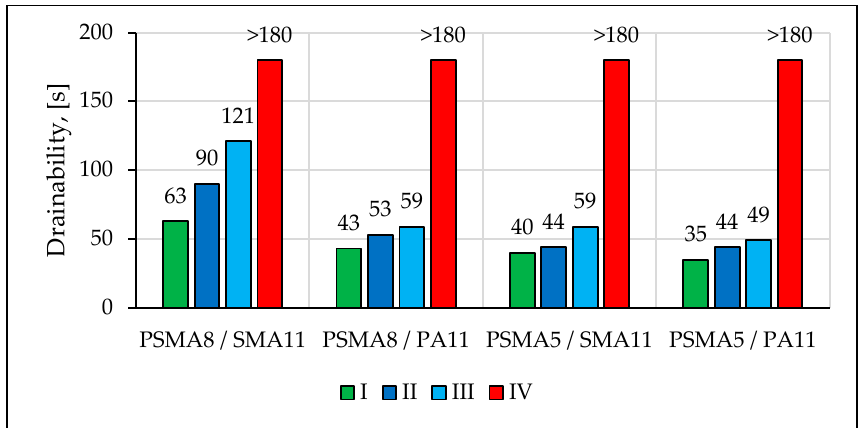
Figure 19. Changes in sound absorption coefficient during pavement service on test sections.